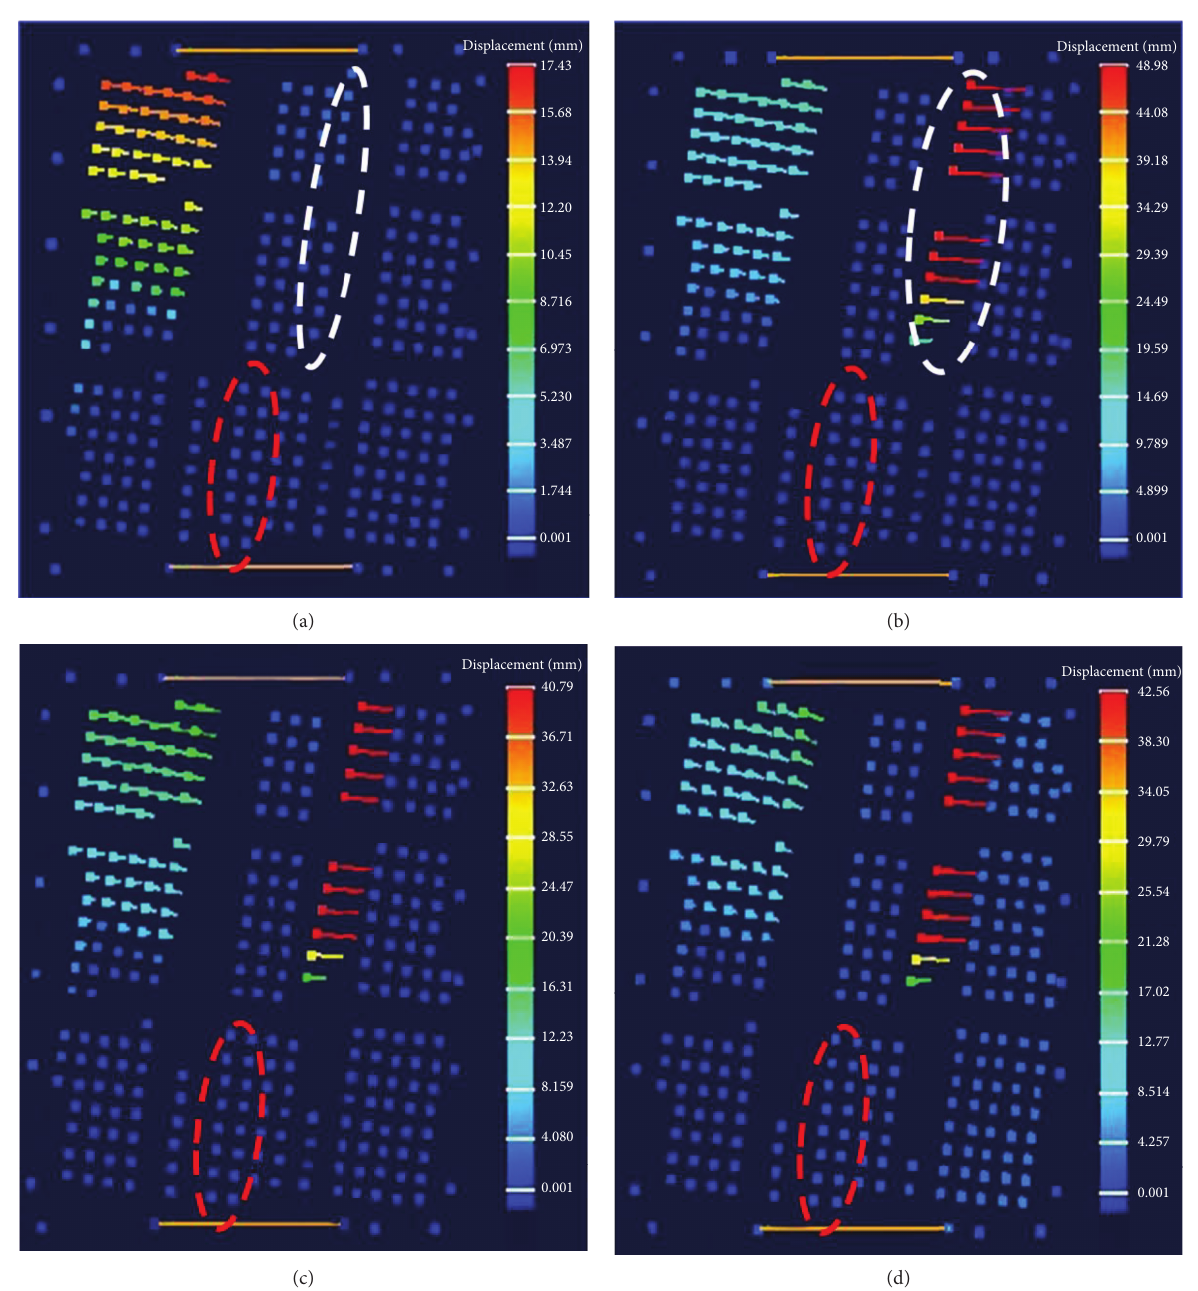
Figure 6: The vectograph of overburden strata. (a) +525m level. (b) +500m level. (c) +475 m level. (d) +450 m